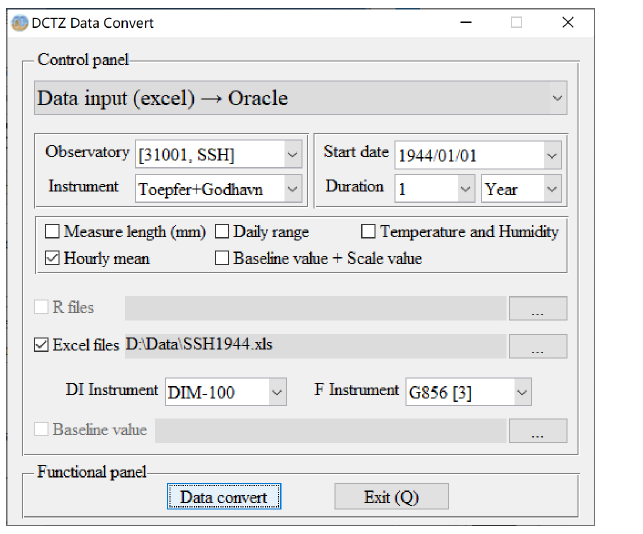
Figure 3. Data import